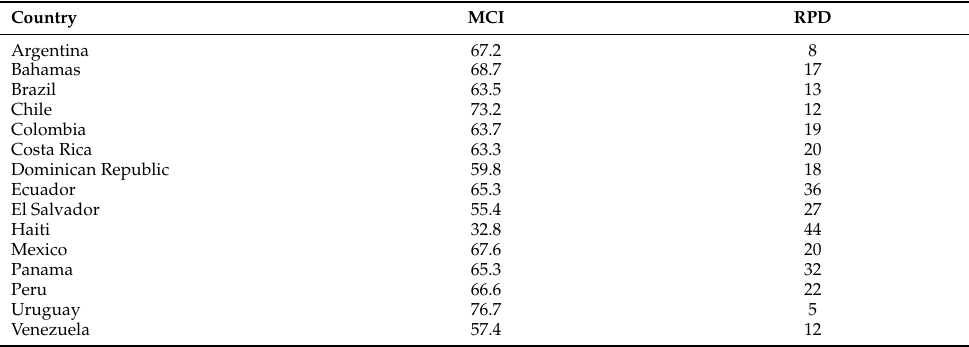
Table 1. Contrast between MCI and RPD of 15 Latin America countries